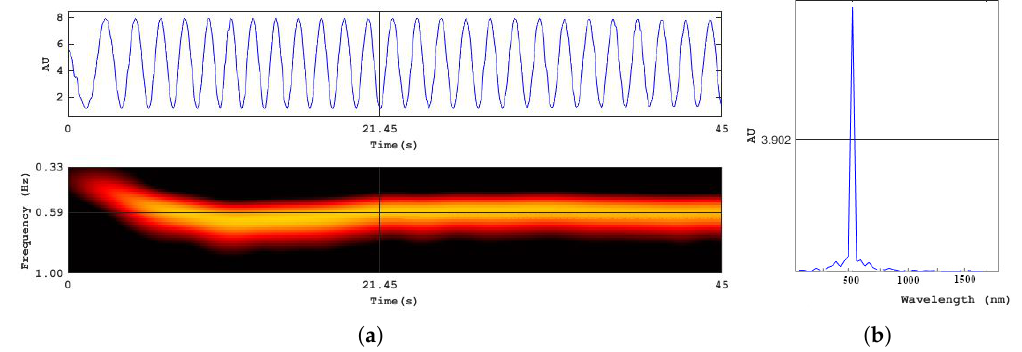
Figure 10. Motion of the reference mirror, spectral resolution of the interferometer; ( a ) An interfer- ogram registered in a single pixel during mirror displacement; S-Transform of the interferogram, showing frequency shift due to nonlinear motion; ( b ) Spectrum of the linear part of the